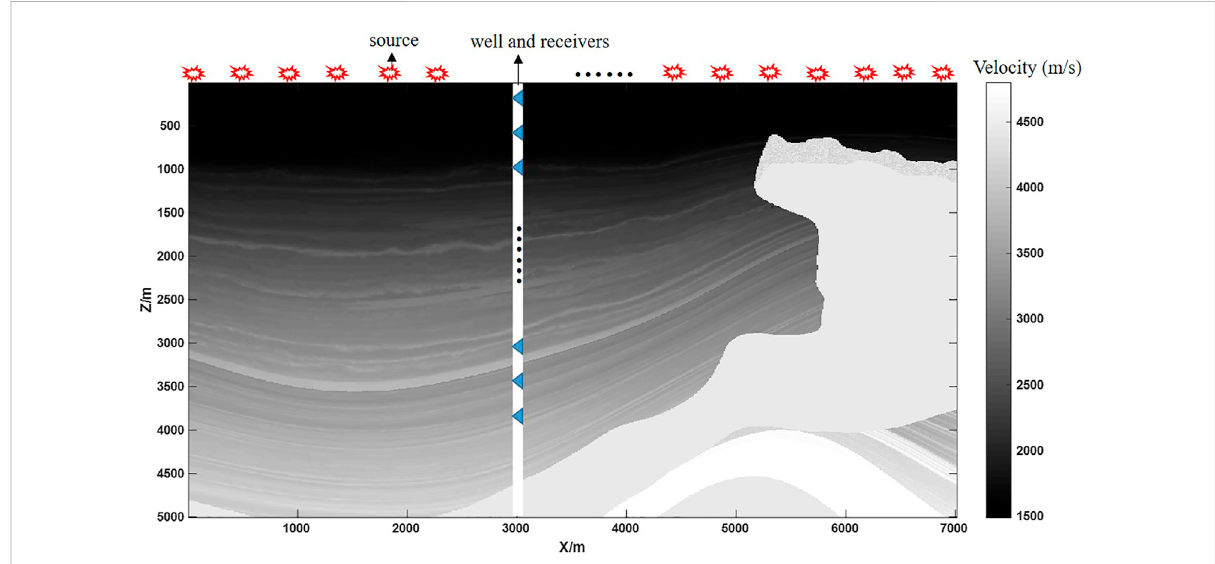
FIGURE 2 Two-dimensional pro fi le of the SEAM model and the acquisition geometry.